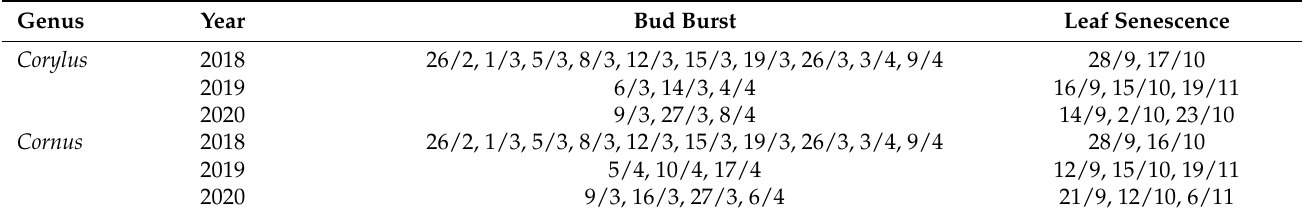
Table 2. Observation dates for bud burst and leaf